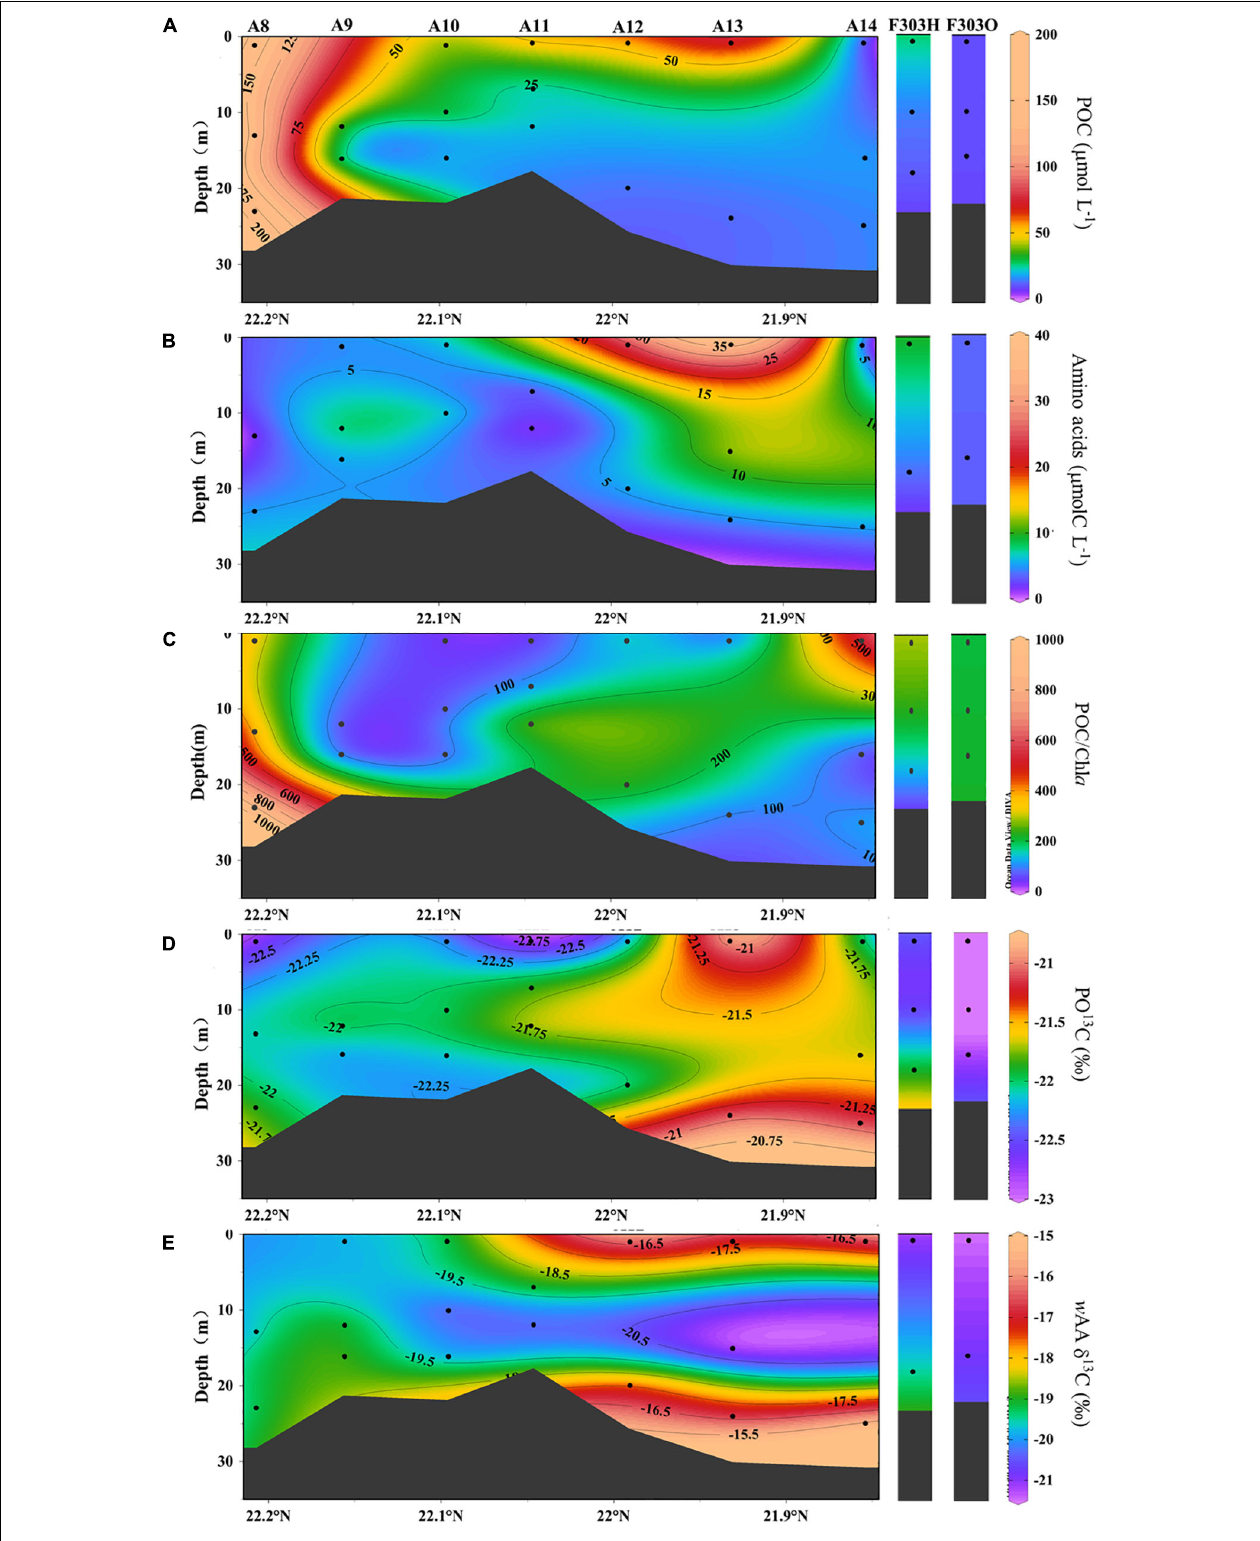
FIGURE 3 | Concentrations of particulate organic carbon (A) , amino acids (B) and POC/Chl a (C) , particulate organic carbon δ 13 C, PO 13 C (D) and carbon-weighted mean of amino acid δ 13 C, w AA δ 13 C (E) from transect A and station F303 on the NSCS shelf. Station F303H and F303O are the two visits to station F303 before and after Tropical Storm Son-Tinh,